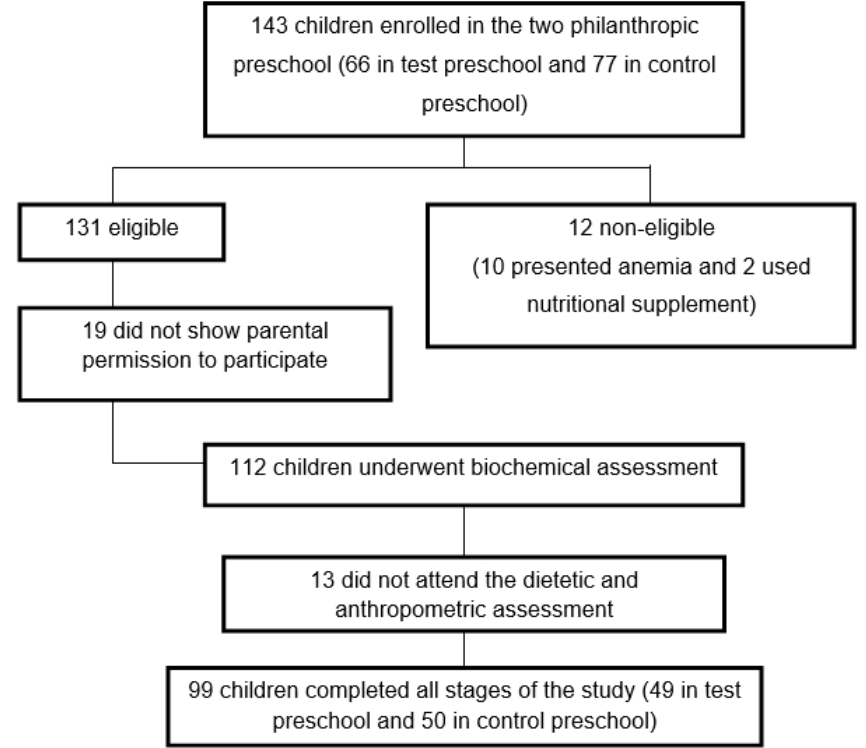
Figure 1. Diagram of the sample selection of children enrolled in the two philanthropic preschools.